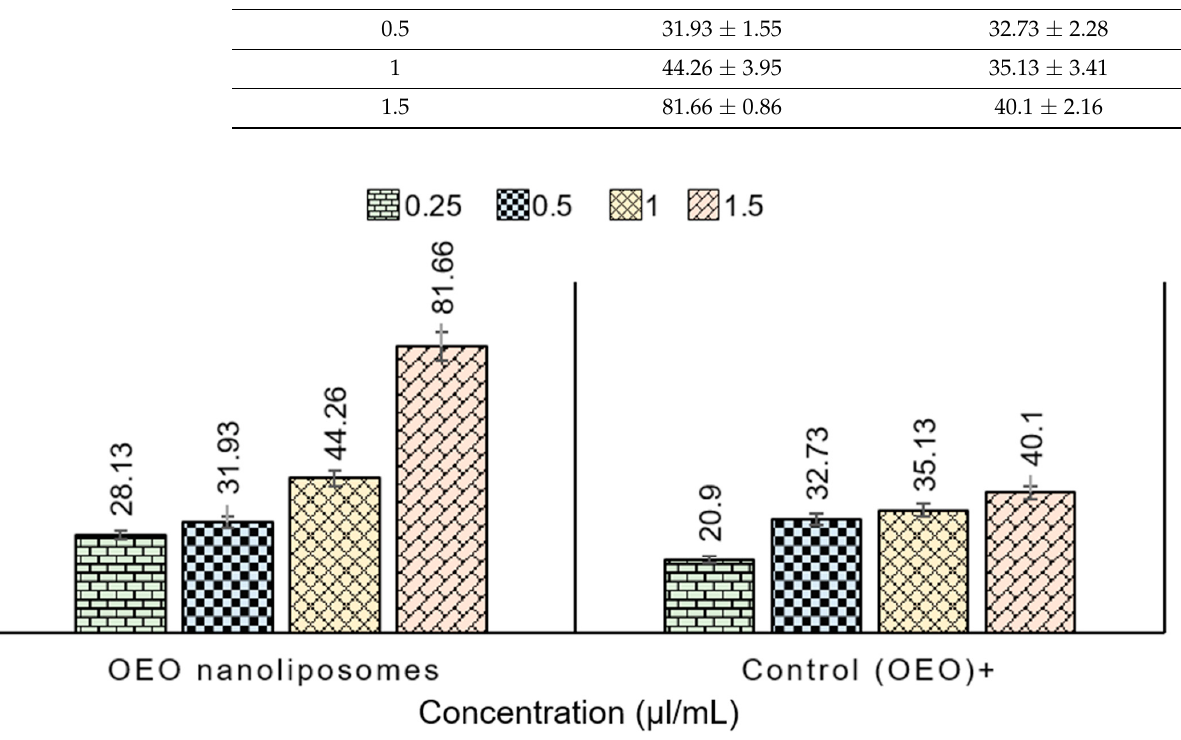
Figure 7. Evaluation of antifungal activity of EO nanoliposomes (OEO) against T. rubrum strains. The analysis was per- formed at four different concentrations for all the samples and the %MGI was calculated according to the formula de- scribed in the experimental section. Table 4. Mycelial growth inhibition (MGI) of OEO nanoliposomes. Pure OEO was taken as a posi- tive control and empty nanoliposomes were taken as a negative control. Data are expressed as mean values ± standard deviation.